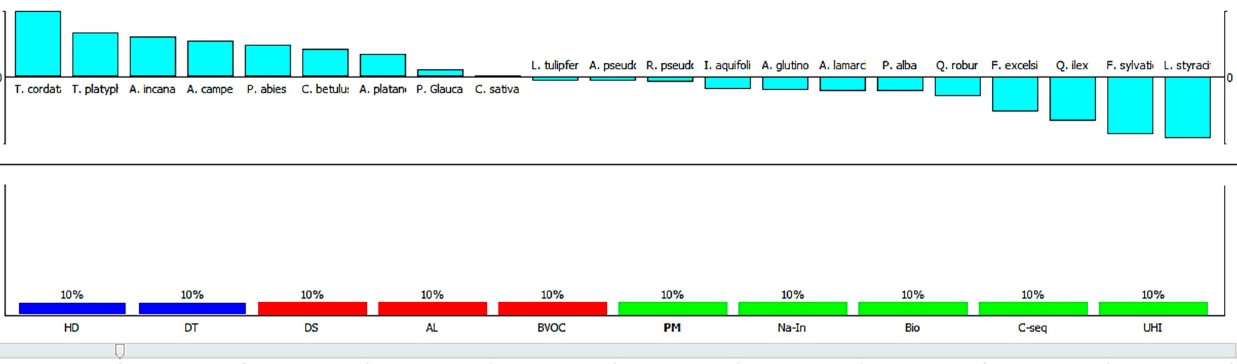
Figure 1 . The upper part of the bar chart shows the ranking of plant species. The lower part is a bar chart with each criterion assigned equal weights (hardiness for low temperatures and drought tolerance (dark blue bars), disease susceptibility, allergenicity and BVOC emissions (red bars), PM mitigation, native-invasive, supporting biodiversity, net carbon sequestration, and reducing urban heat island effect (green bars)) included in the services and disservices model. (For an interpretation of the references to color in this figure legend, the reader is referred to the web version of this article.)